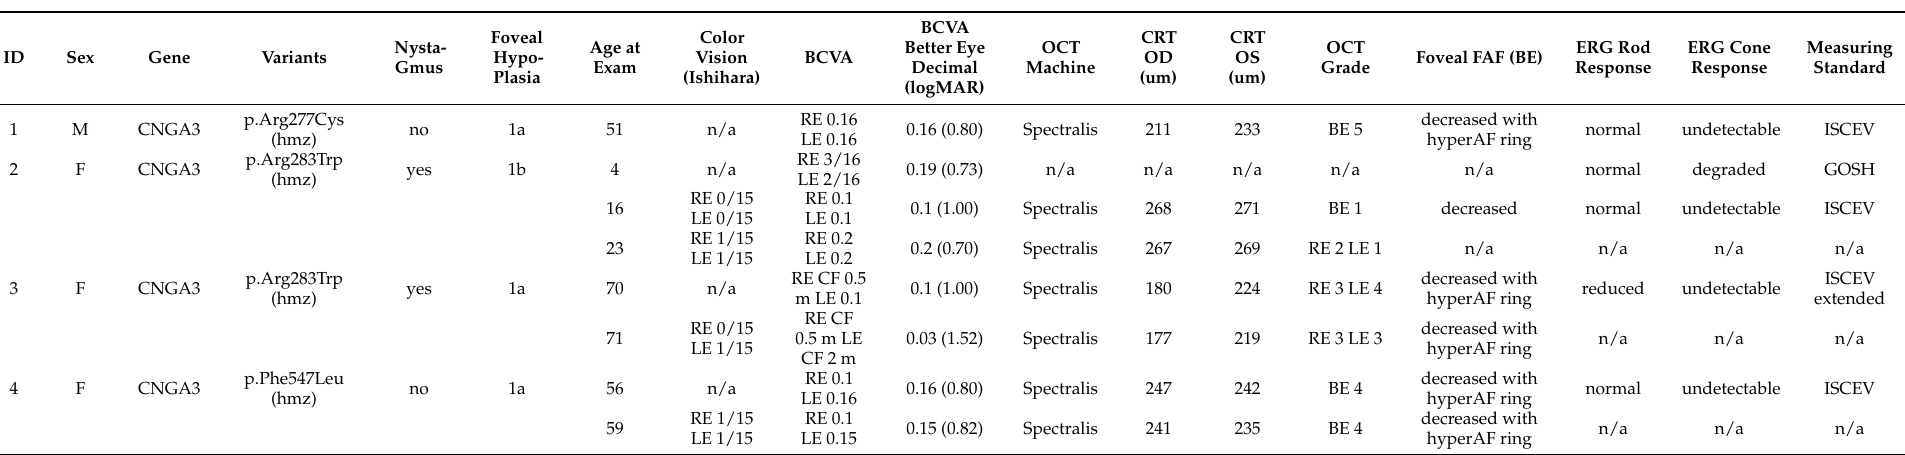
Table 2. Spectrum of the identified CNGA3 and CNGB3 variants in the studied Slovene